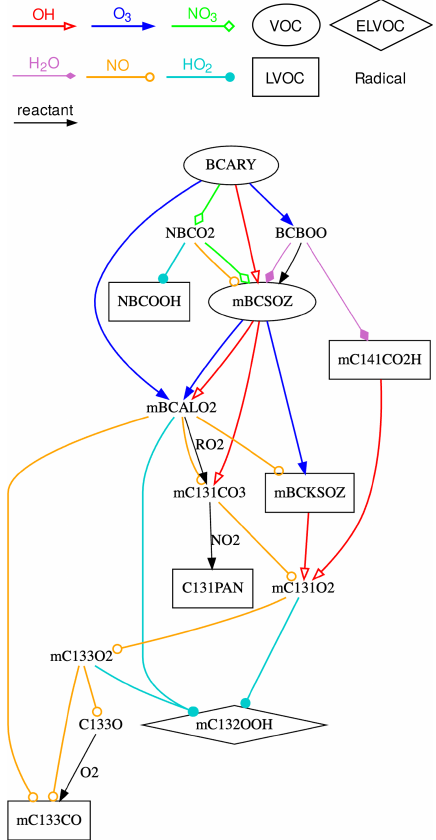
Figure 5. Representation of the chemical scheme of the Rdc. mech- anism. VOCs, LVOCs, and ELVOCs are presented in ellipse, square, and diamond boxes, respectively. Radicals are written in plain text, without boxes. Reactions with OH, O 3 , NO 3 , NO, HO 2 , and H 2 O are shown using arrows with different colors and heads (see the fig- ure legend). Other reactants (if any) are labeled near the edges. The complete species and reaction lists of the Rdc. mechanism are given in Appendix Tables B1 and B2, respectively.